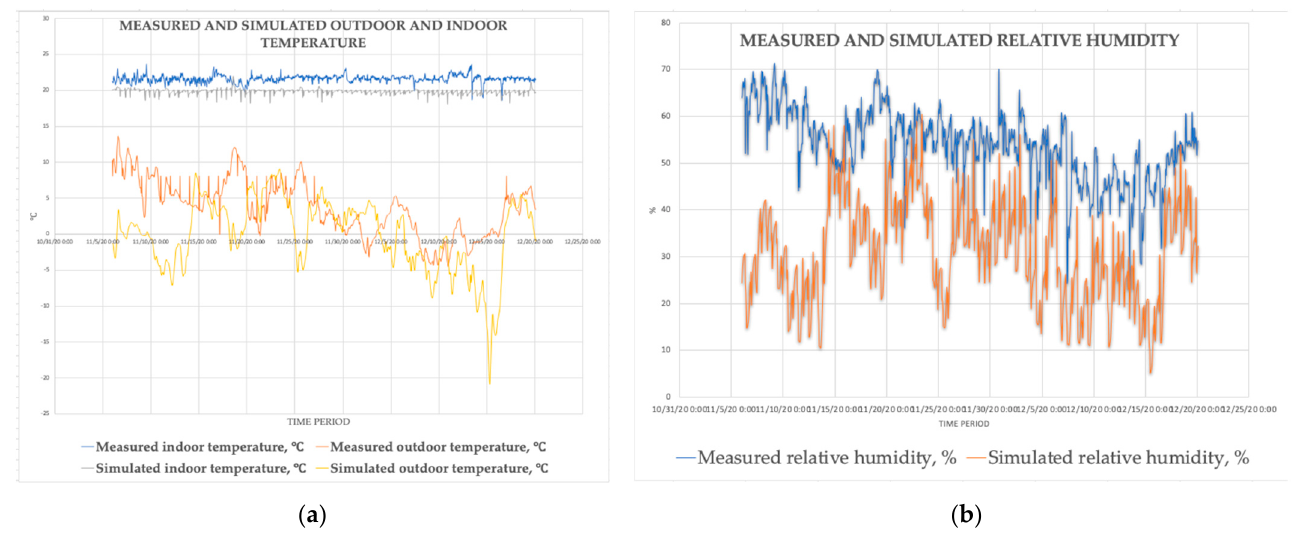
Figure 4. ( a ) Measured and simulated outdoor and indoor temperature; ( b ) measured and simulated relative humidity.